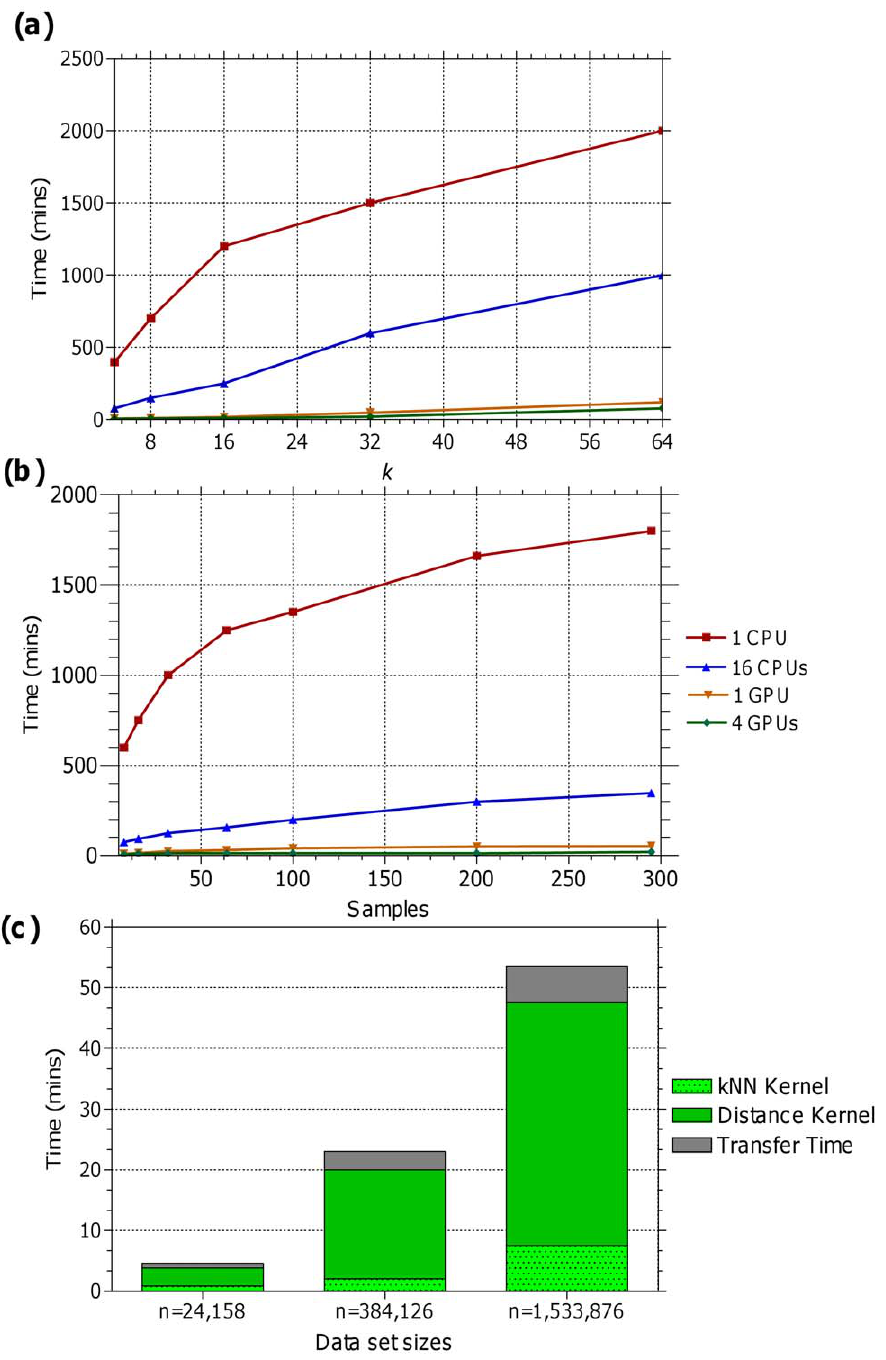
Figure 4. Performance of the GPU-FS- k NN. Figure (a) and (b) show the computation times observed for different values of k (with a fixed sample size of 100) and sample sizes (with a fixed value of k ~ 20 ), respectively, on the expanded_A data set. It is evident from these figures that even with an increase in the value of k or sample size, the execution time remains comparably stable on the GPU-based implementation. Figure (c) shows the computation times observed for the Distance kernel, kNN Kernel and data transfer from host to device on the three data sets, using a single GPU, k ~ 20 and a total of 295 samples. Although the distance computation takes most of the execution time here, further optimization to this kernel (e.g., vectorization) can improve the overall speed-ups. doi:10.1371/journal.pone.0044000.g004 work, we only discuss the details of the computational partitioning i.e., chunking of the distance matrix and subsequent identification The input data set is represented in the form of a matrix, where method of k NNs from the chunks. each row represents a point and the respective columns represent the dimensions of the point. The complete input matrix contains